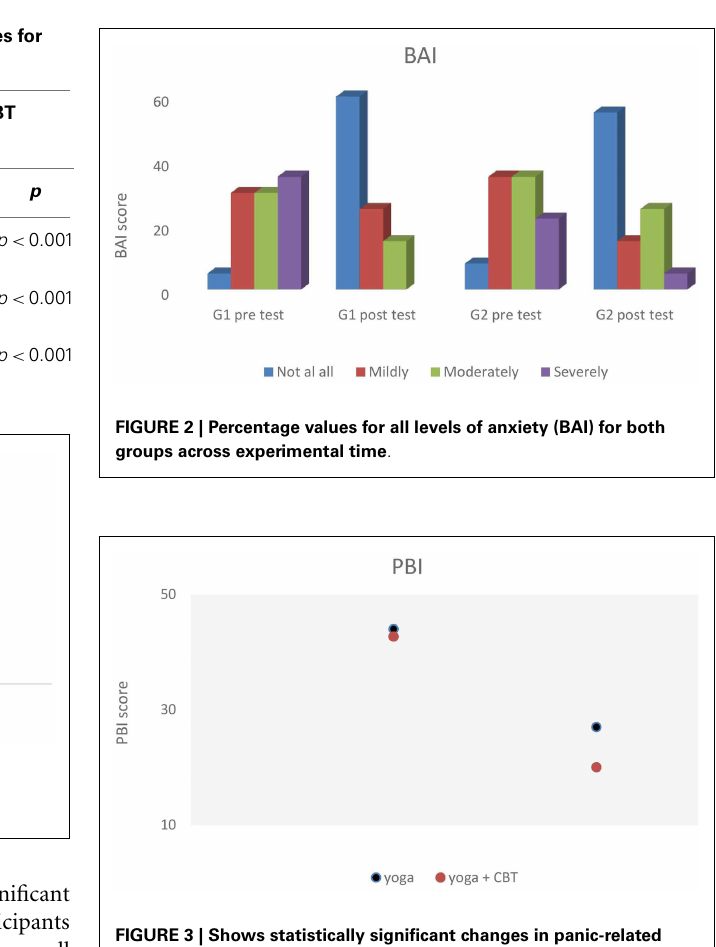
FIGURE 3 | Shows statistically significant changes in panic-related beliefs (panic belief inventory) from baseline to end-program (pre- and post-test), for both experimental groups